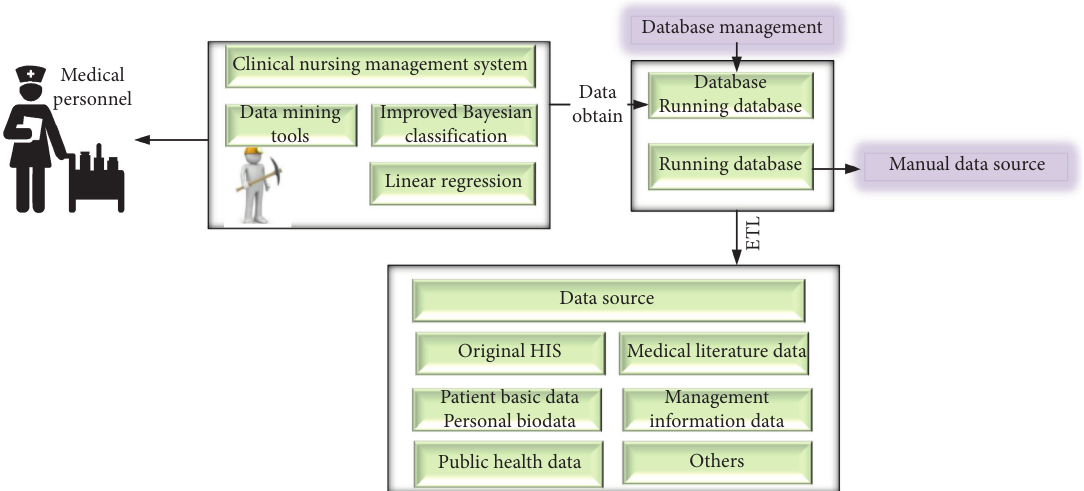
Figure 1: The optimization of the architecture diagram of the data warehouse in this